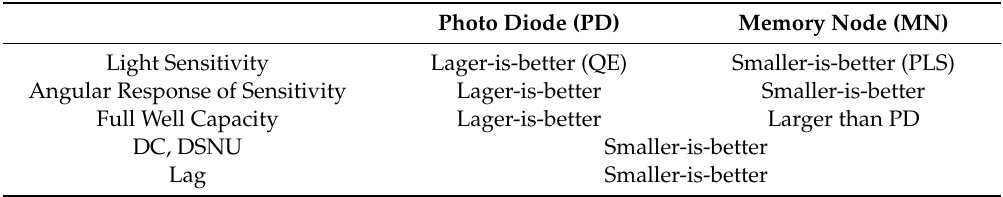
Table 1. Figure of merit for charge